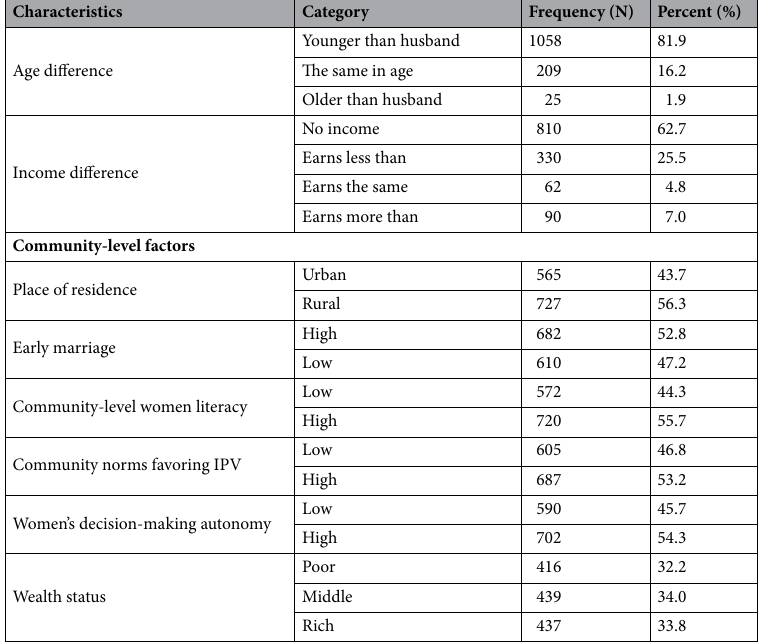
Table 1. Individual-and community-level characteristics of currently married postpartum women in Wolaita zone, Southern Ethiopia, 2020. *=Others: Catholics, Muslim, Jehovah witness.